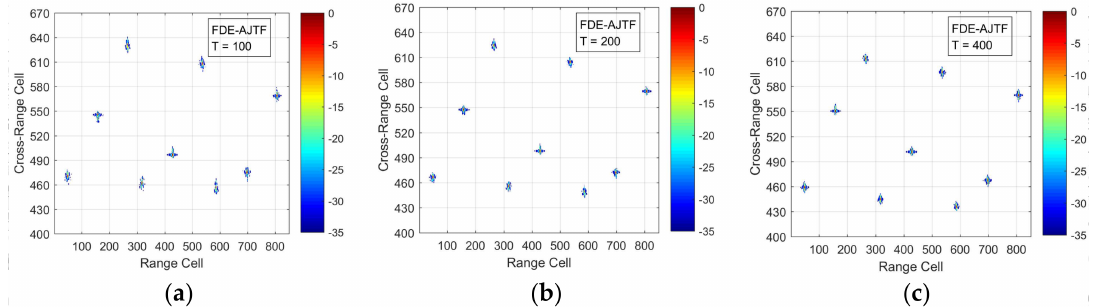
Figure 5. Imaging results by FDE–AJTF method. ( a ) T = 100; ( b ) T = 200; and ( c ) T =